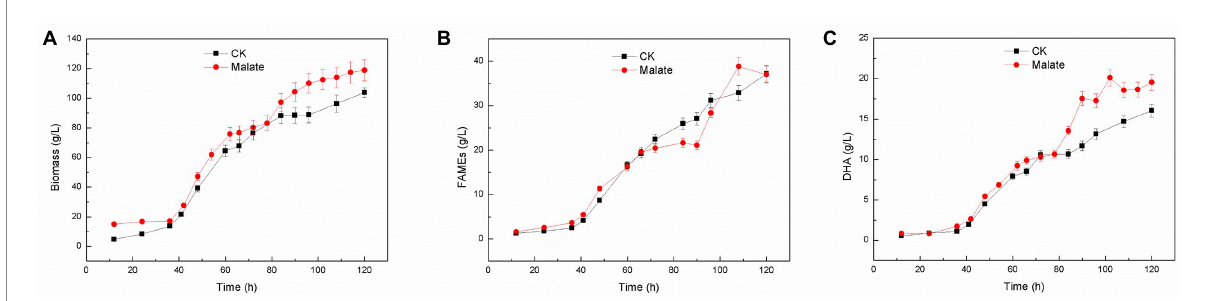
FIGURE 2 Time course (growth characteristics) of changes in DHA production in Schizochytrium sp. FJU-512 grown with or without malate. Each point is the mean ± SD of three independent experiment replicates. Error bars represent the standard error of the means. CK: control group (no malate addition); Malate: 3 g/l malate added at 60 h. (A) Growth curve. (B) FAME (%) was calculated at different time intervals. (C) DHA concentration (g/L) at different time